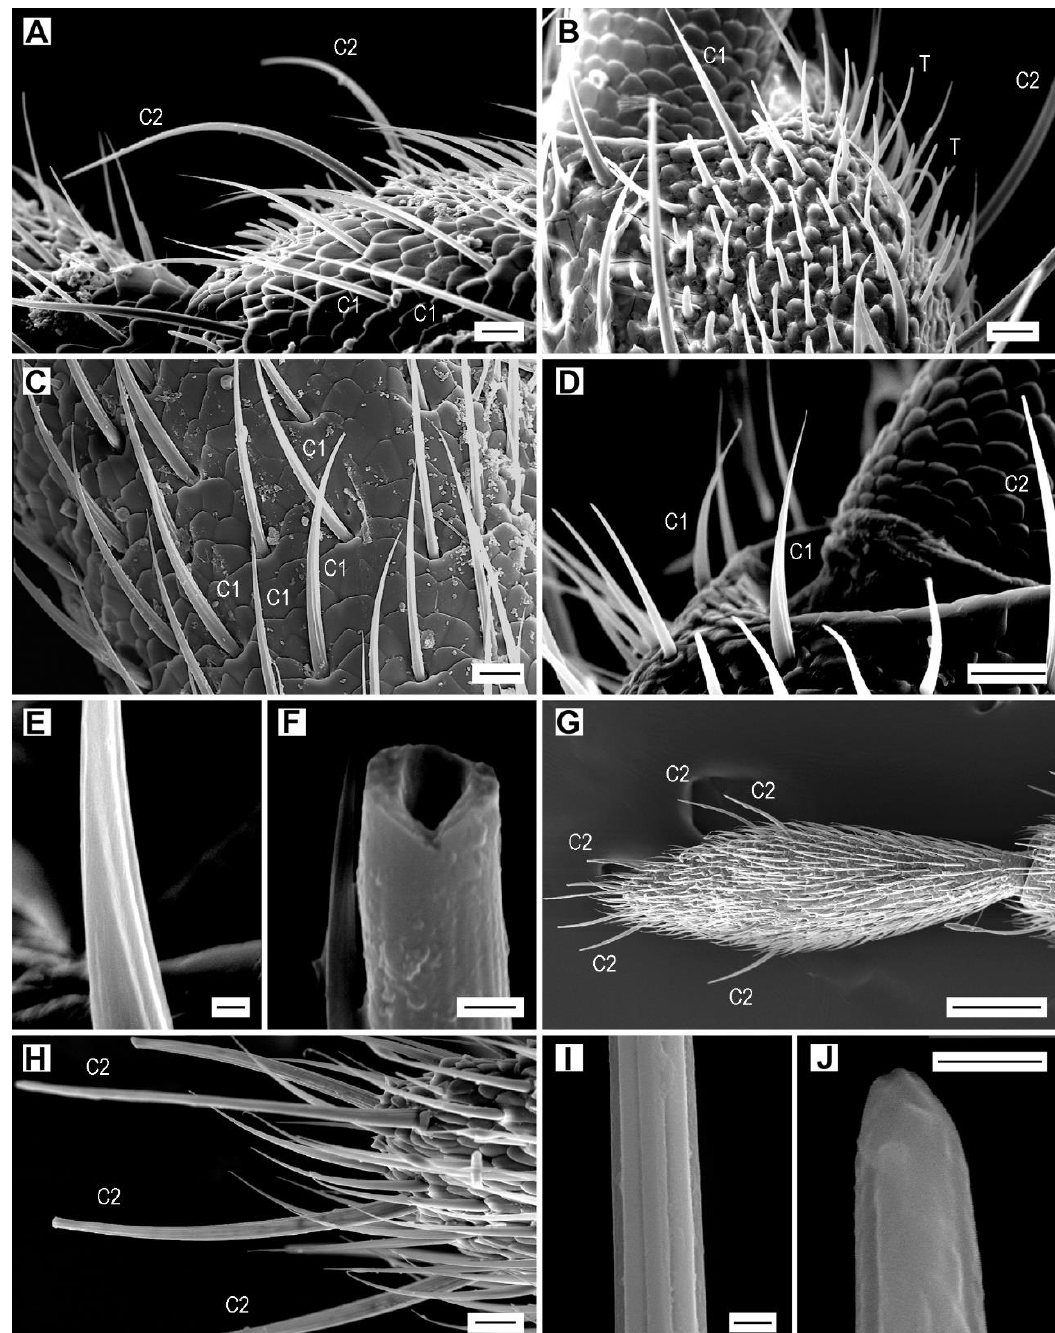
Figure 4. Sensilla chaetica. ( A ) A. acuminatus , male, numerous sensilla chaetica C1 and C2 on antennomere III; ( B ) A. lineatus , male, sensilla chaetica and trichodea; ( C ) A. obscurus , male, sensilla chaetica C1; ( D ) A. medvedevi , male, sensilla chaetica C1 and C2; ( E ) A. medvedevi , male, detail of the wall of sensillum C1; ( F ) A. pilosellus , male, broken sensillum C1; ( G ) A. modestus , female, antennomere XI, dorsally, sensilla chaetica C1 and C2; ( H ) dtto, detail; ( I ) A. modestus , female, striae on the wall of sensillum C2; ( J ) A. obscurus , male, apex of sensillum C2. Scale bars = ( A–D , H ): 10 μm; ( E , F , I , J ): 1 μm; ( G ): 100 μm.